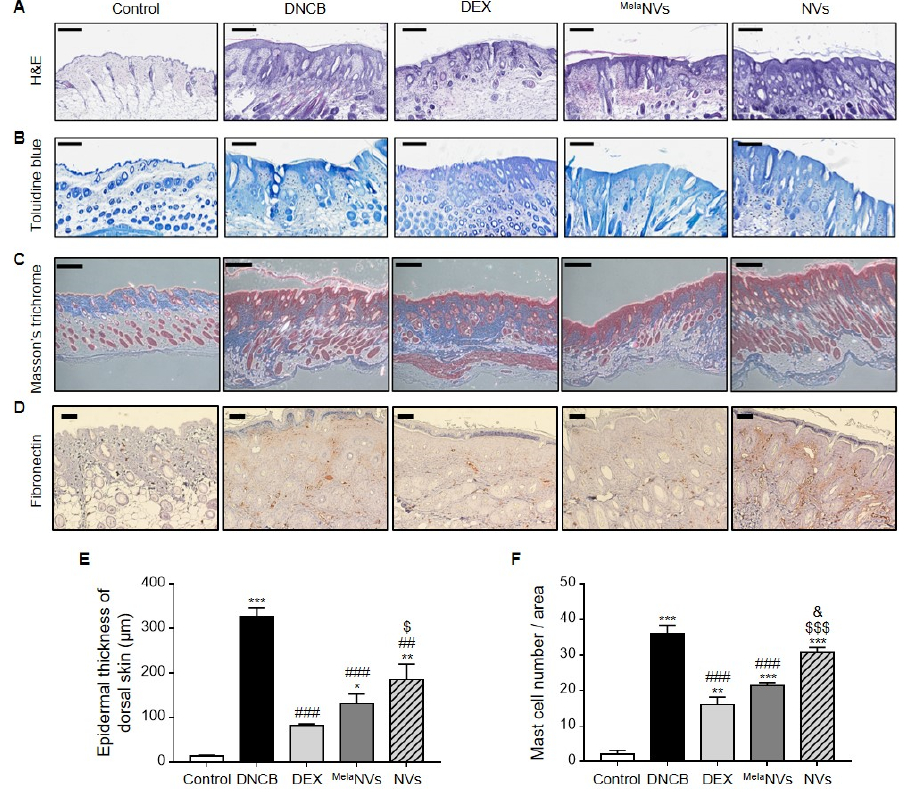
Figure 4. Mela NVs treatment decreases epidermal thickness and suppresses mast cell infiltration and fibrosis in AD-like skin lesions. ( A – D ) Representative images of hematoxylin and eosin (H&E) staining (scale bar, 300 μ m) ( A ), toluidine blue staining (scale bar, 200 µ m) ( B ), Masson’s trichrome Scheme 100 μ m) ( C ), and immunohistochemical staining (scale bar, 100 μ m) ( D ) of dorsal skin of mice in each group. ( E ) Comparison of epidermal thickness of dorsal skin lesions for different experimental groups determined by H&E staining. ( F ) Observed infiltration of mast cells in dorsal skin lesions determined by toluidine blue staining. Data are presented as mean ± SEM. * p < 0.05, ** p < 0.01, *** p < 0.001 vs. control, ## p < 0.01, ### p < 0.001 vs. DNCB group, $ p < 0.01, $$$ p < 0.001 vs. DEX group, & p < 0.05 vs. Mela NVs group.